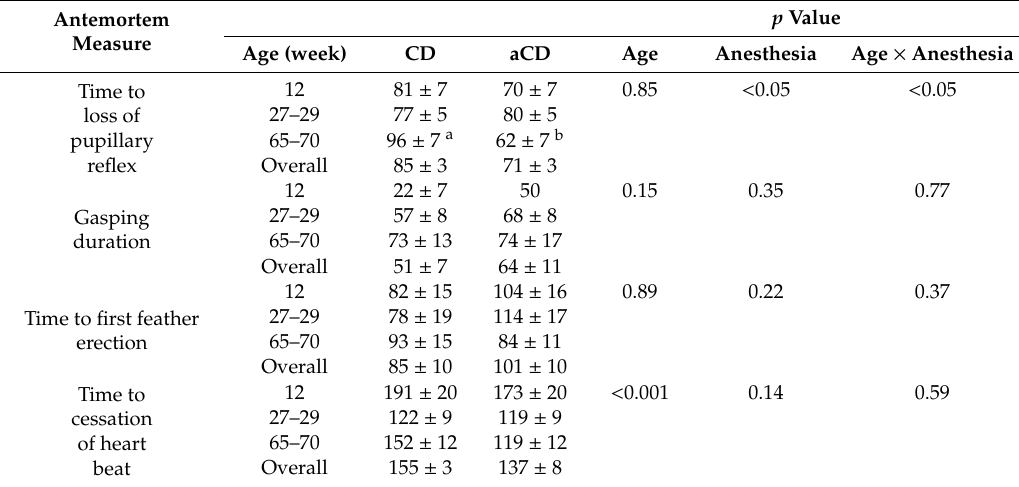
Table 6. Mean latencies to or durations of ( ± SE s) antemortem measures in conscious and anesthetized chickens killed by manual cervical dislocation in di ff erent age groups. p values are given for e ff ects of age, anesthesia, and age-by-anesthesia